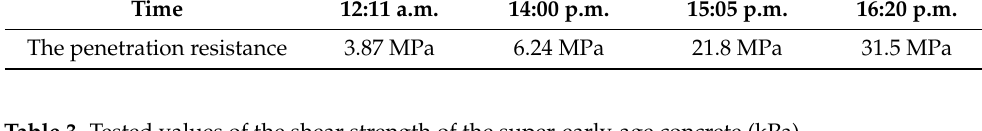
Table 2. Tested values of the penetration resistance of the super-early-age concrete. Time